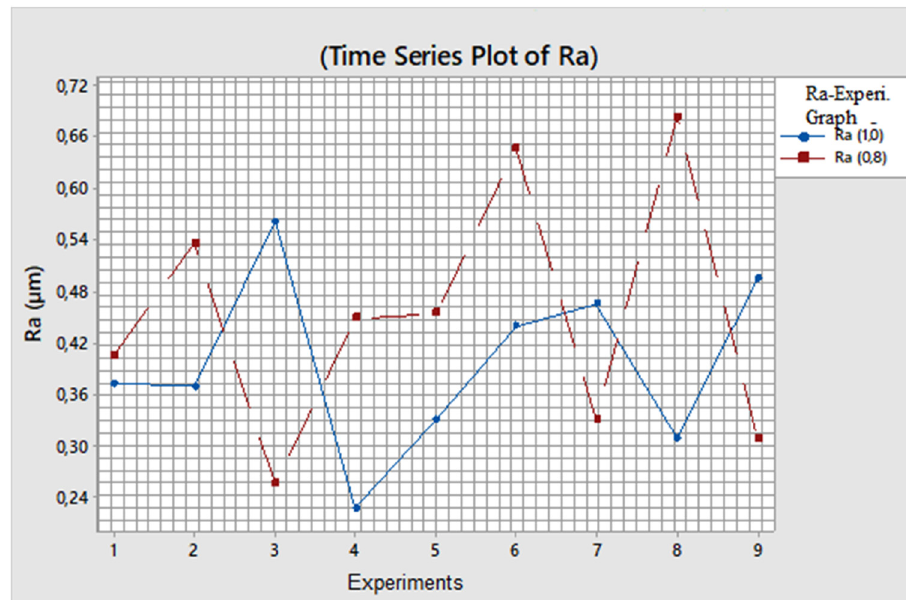
Figure 3: Comparison of surface roughness.